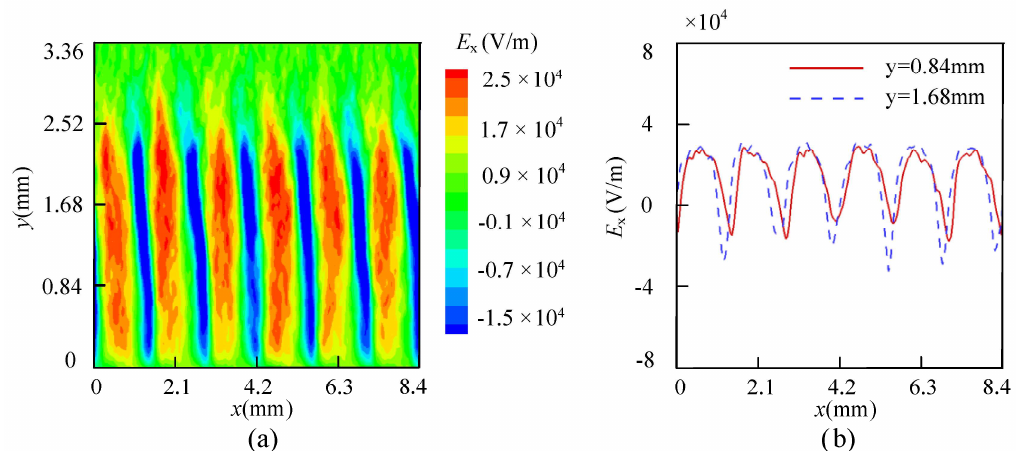
Figure 5. Distribution of electric field in ( a ) two-dimensional and ( b ) one-dimensional space along azimuth at y = 0.84 mm and y = 1.68 mm with E ⊥ B .